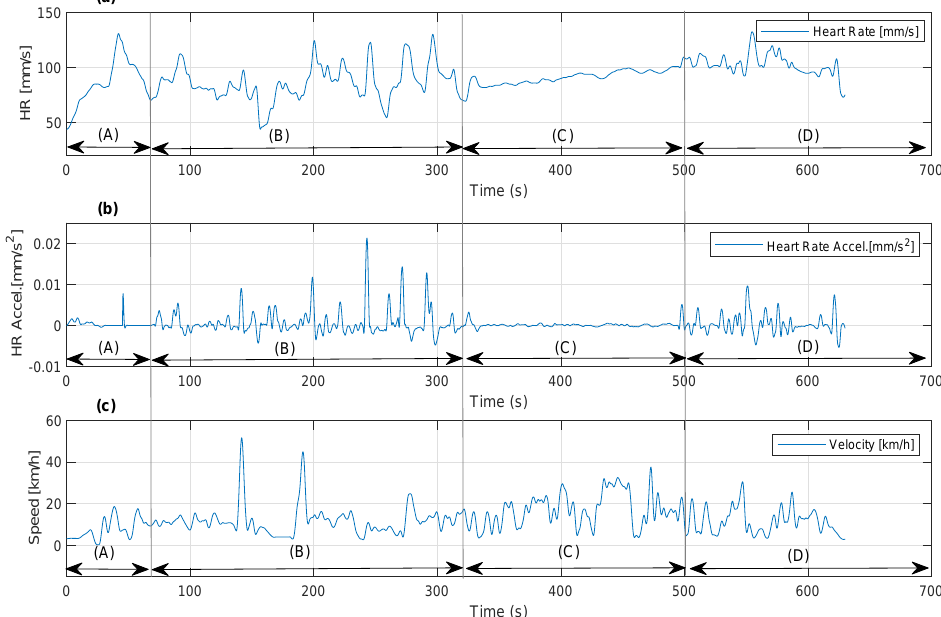
Figure 13. Experimental results, with the following variables: ( a ) HR in BPM, ( b ) HR acceleration mm/s 2 , and ( c ) speed km/h.